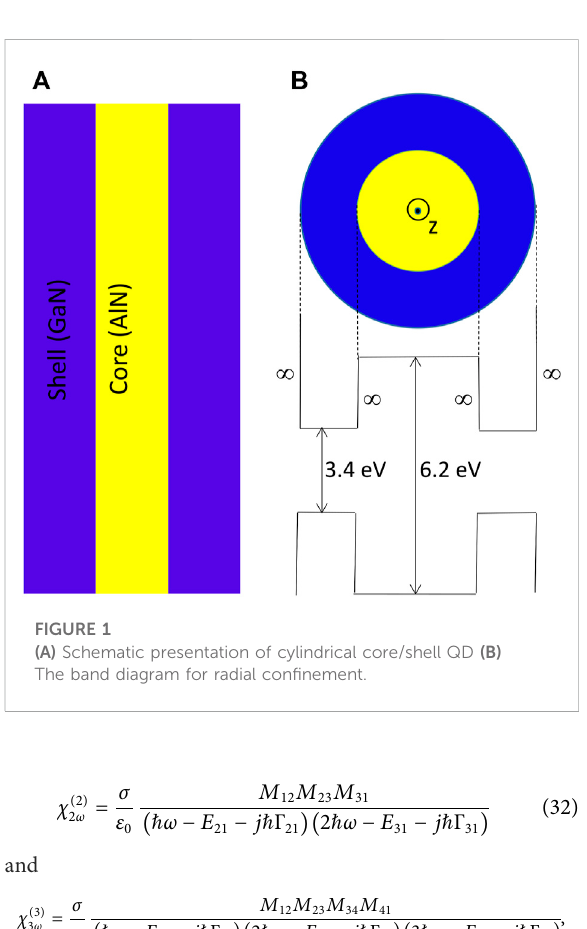
FIGURE 1 (A) Schematic presentation of cylindrical core/shell QD (B) The band diagram for radial con fi nement.